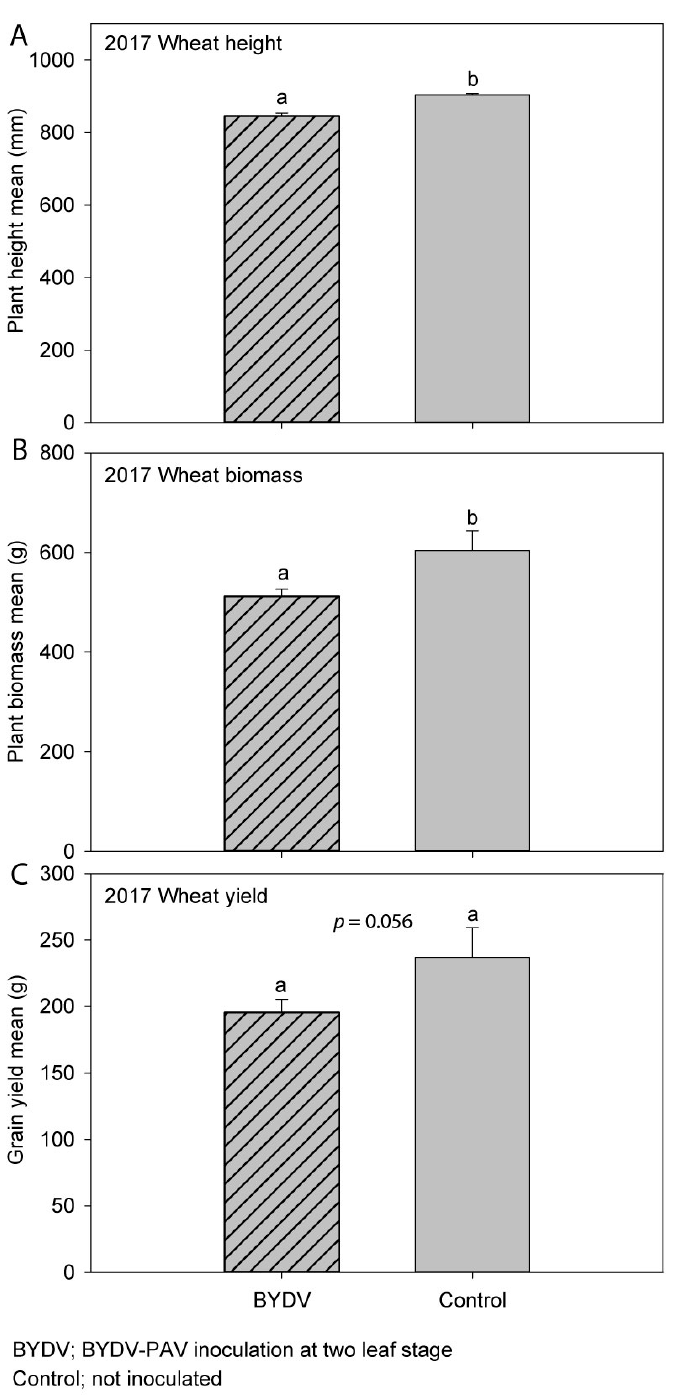
Figure 3. The effect of early (BYDV) or no (Control) BYDV-PAV inoculation on: ( A ) plant height; ( B ) plant biomass; ( C ) grain yield of wheat in experiment 3 (2017) in South-Eastern Australia. Error bars represent standard error; means with the same letter are not significantly different at p < 0.05.